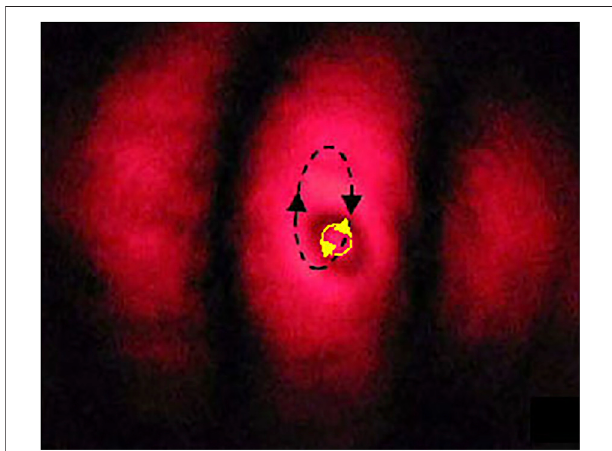
FIGURE14| Positionoftheparticletrappedwithinthecentrallobeofthe interference pattern [143]. Black dashed line shows its center-of-mass trajectory; simultaneously, the particle spins near its center of mass (yellow